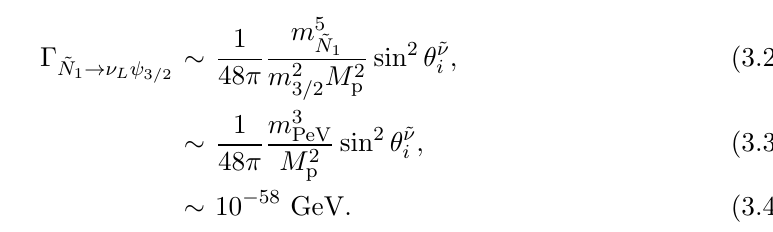
Figure 2 . Feynman diagrams corresponding to the decay mode ~ N 1 ! (cid:23) L h 0 (a) and (b) show interactions which proceed through the Yukawa interaction with coupling y N , whereas diagram (c) proceeds through the trilinear interaction with strength proportional to A N